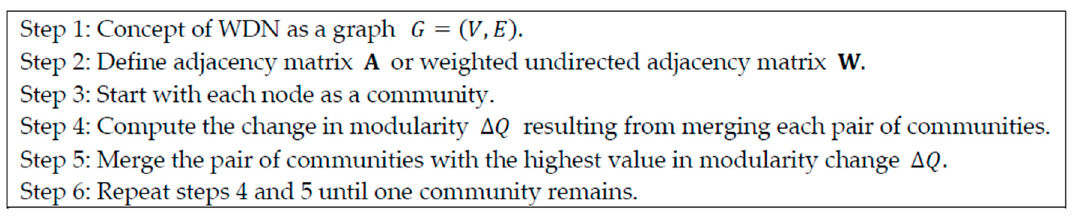
Figure 4. Main steps for community structure algorithm clustering.